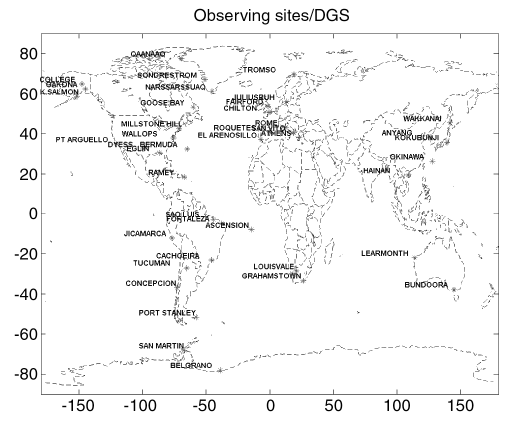
Fig. 1. Observing sites available for the periods ana- lyzed.